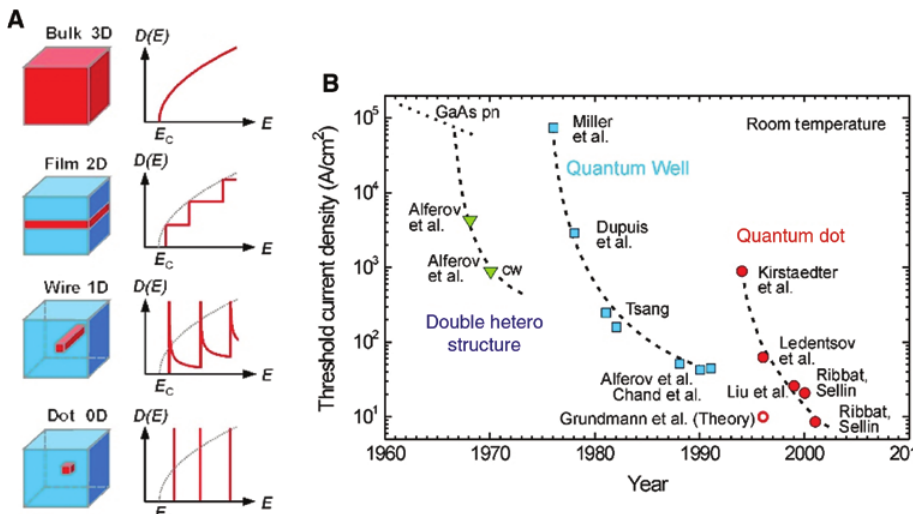
Figure 4: Effect of reduced dimensionality. (A) Charge carriers are confined in a semiconductor (red) with a smaller bandgap than the cladding semiconductor (blue). The confinement changes the density of states D(E). E is the conduction-band edge of a 3D semiconductor, from Ref. [4]. (B) Development of the threshold c current density of semiconductor lasers between their invention and the rord values for QD-lasers.